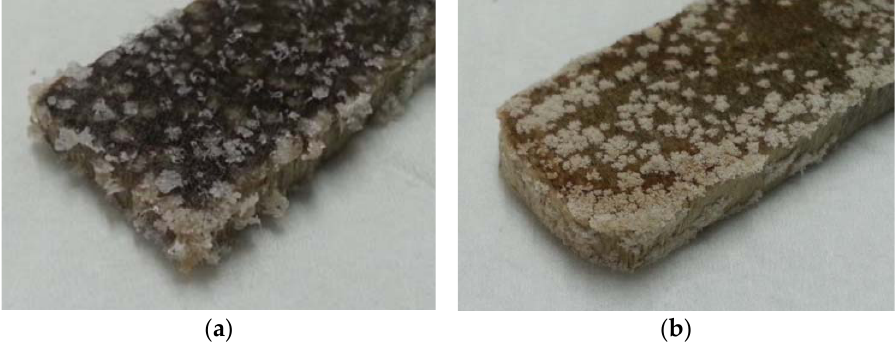
Figure 4. Dry samples of beech ( a ) and oak ( b ) after three